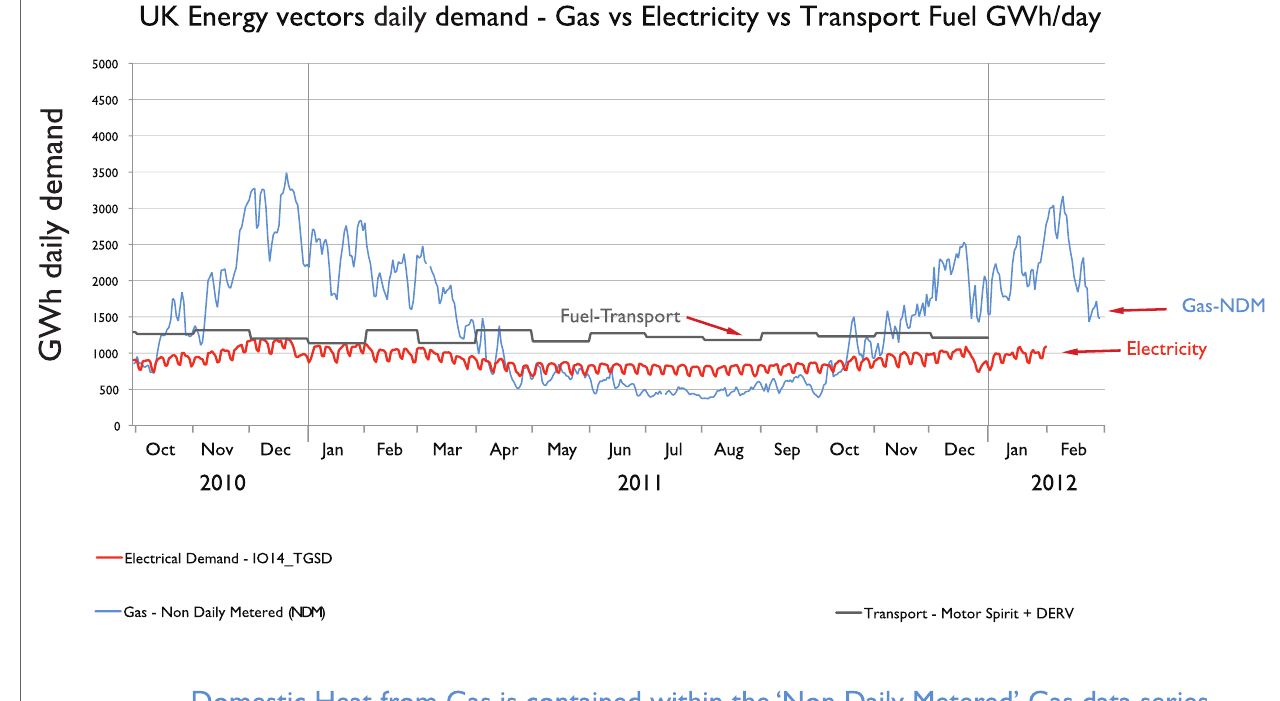
FiGUre 3 | initial saed presenting the three major demands on a daily basis